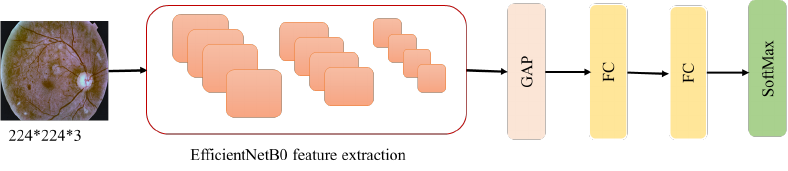
Figure 10. Transfer learning